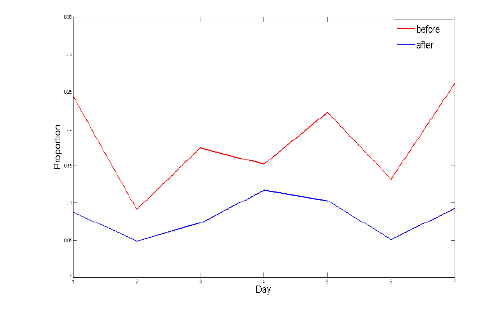
Figure 7. The data correction result